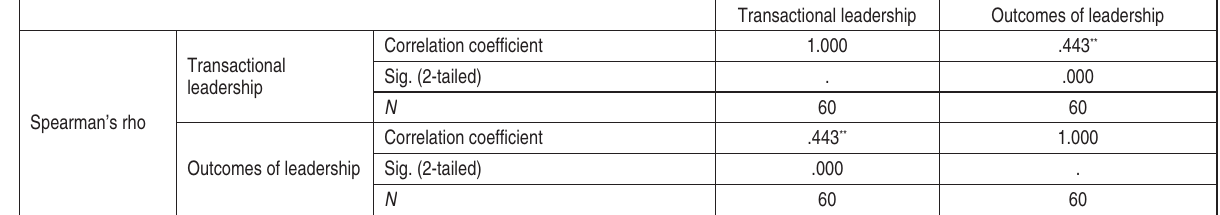
Table 7. Correlations between transactional leadership and outcomes of leadership